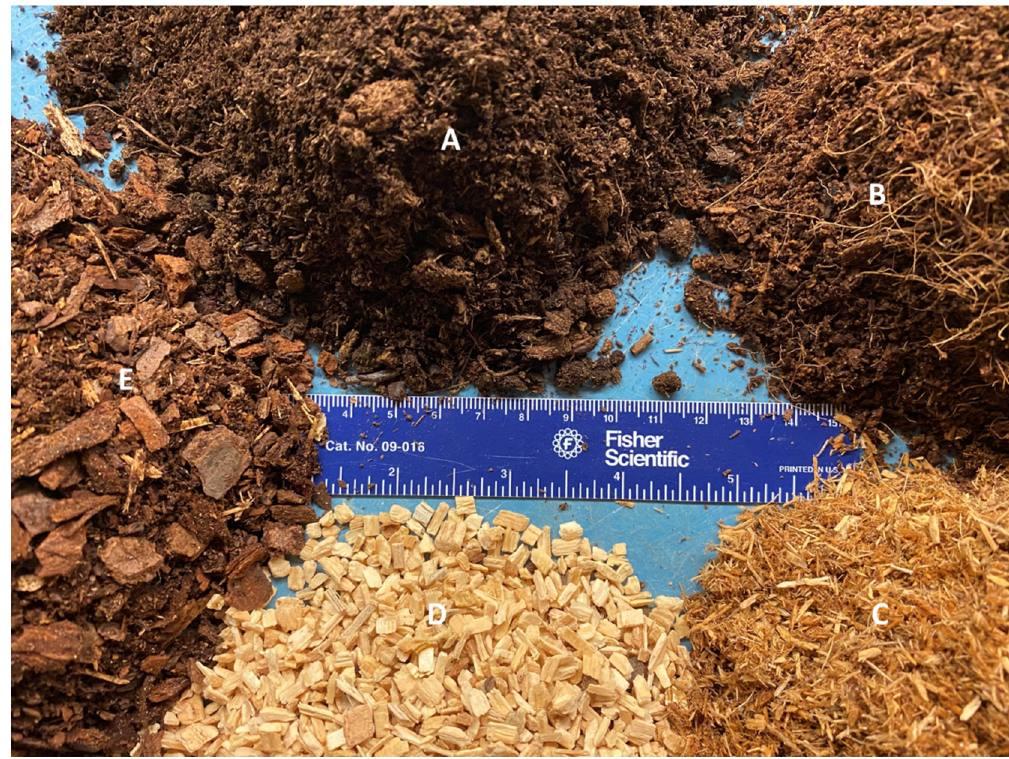
Figure 1. Examples of the base materials used in this research, including ( A ) Sphagnum peat moss; ( B ) coconut coir pith; ( C ) shredded pine wood; ( D ) pine wood chips; and ( E ) aged pine bark.